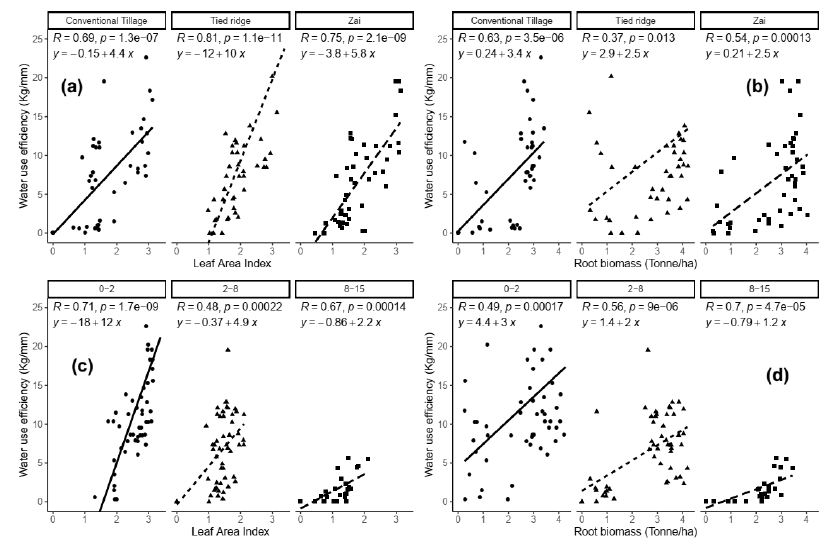
Figure 7. Relationships between the WUE and maize growth parameters under selected SWC practices ( a , b ) along the slope gradient ( c , d ).